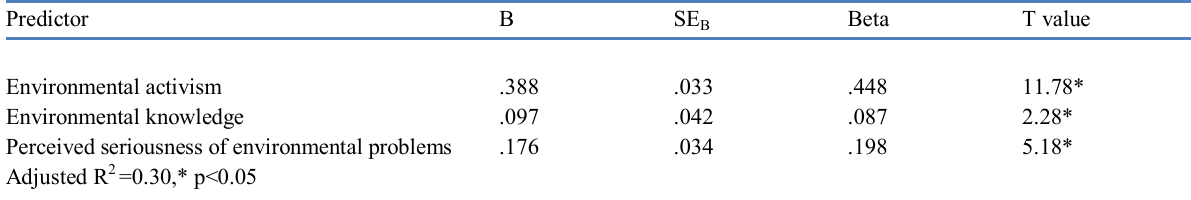
Predictor B SE B Beta T value